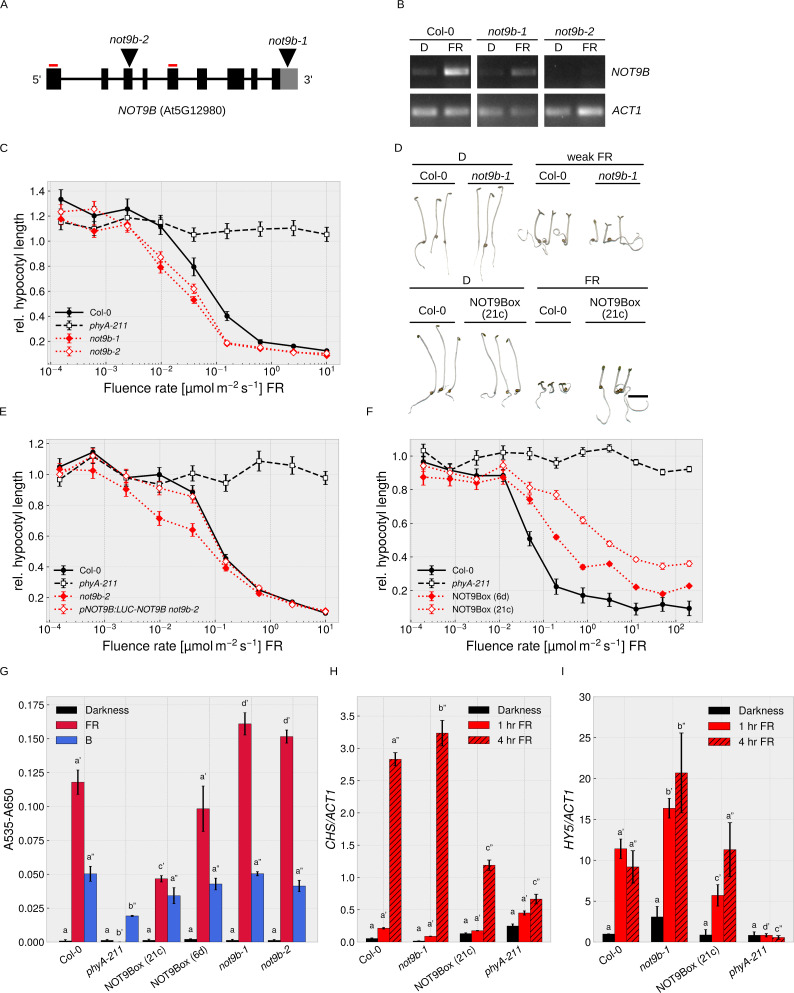
NOT9B is a negative regulator of phyA-mediated light signalling.(A) NOT9B T-DNA insertion mutants. Schematic drawing of the NOT9B genomic locus. T-DNA insertions in not9b-1 and not9b-2 are shown as triangles and primers used for RT-PCR in (B) as red lines. Black boxes, exons; black lines, introns; grey box, 3’ UTR. (B) RT-PCR for not9b alleles. Four-day-old dark-grown Col-0, not9b-1, and not9b-2 seedlings were exposed to FR light for 24 hr (FR) or kept in the dark. Total RNA was extracted and NOT9B and ACT1 transcripts were detected by RT-PCR and agarose gel electrophoresis. Positions of primers used to detect NOT9B are indicated in (A). ACT1 was used as reference gene. (C), (E), (F) Fluence rate response curves for inhibition of hypocotyl growth. Seedlings of the indicated genotypes were grown for 4 days at different fluence rates of FR light or in the dark. Mean hypocotyl length (±SE) of 20 seedlings relative to dark-grown seedlings is shown. NOT9Box 6d and 21c are two independent lines expressing p35S:HA-YFP-NOT9B. Expression of pNOT9B:LUC-NOT9B was used for complementation of not9-2. (D) Phenotype of not9b-1 and NOT9Box seedlings. Seedlings were grown for 4 days in the dark or in FR light (FR, 10 μmol m−2 s−1; weak FR, 0.05 μmol m−2 s−1). Scale bar represents 2 mm. (G) Quantification of anthocyanin levels in not9b-1 and NOT9Box seedlings. Seedlings of indicated genotypes were grown for 4 days in the dark (D), FR, or B light on ½ MS supplemented with 1.5% sucrose. Anthocyanin was extracted from 25 seedlings per genotype/condition and A535-A650 was measured. Bars represent biological triplicates (± SD). (G)-(I) Letters indicate levels of significance as determined by one-way ANOVA followed by post-hoc Tukeys HSD test; p<0.05. (H and I) Quantification of CHS and HY5 transcript levels in not9b-1 and NOT9Box seedlings. Four-day-old dark-grown seedlings were exposed to FR light for 1 or 4 hr or kept in the dark. Total RNA was extracted and CHS, HY5, and ACT1 transcript levels were quantified by qRT-PCR. Bars represent biological triplicates (± SD).